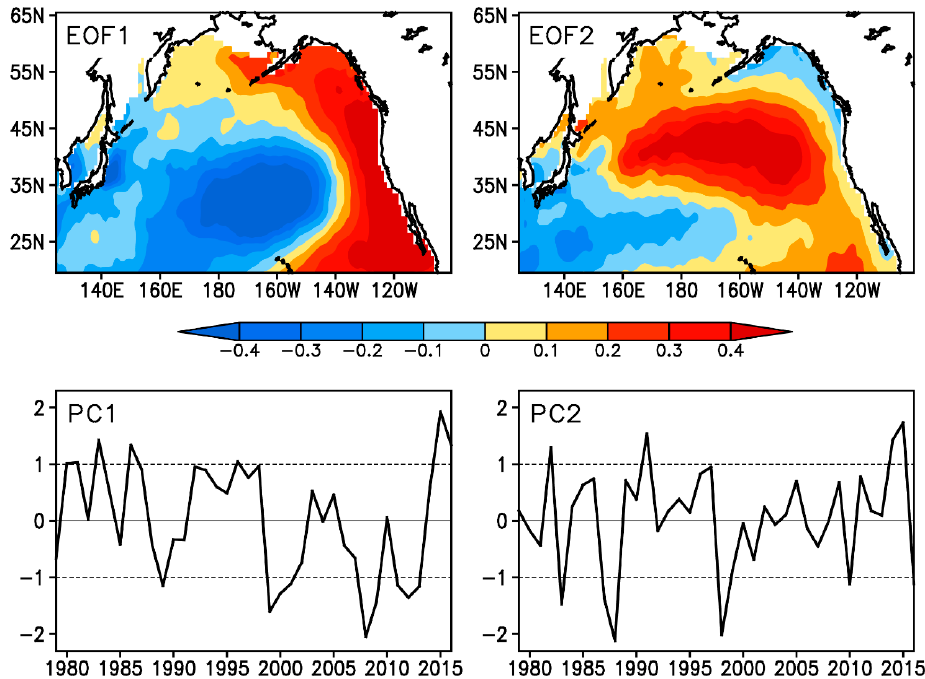
Figure 2. Spatial patterns and corresponding principal components (PCs) of the first two leading EOF (empirical orthogonal function) modes of FMA (February–April)-averaged sea surface temperature (SST) anomalies over the North Pacific poleward of 20° N (after removing the global mean SST anomaly). Table 1. Member years of positive and negative Victoria mode (VM) cases for the period 1979–2017.